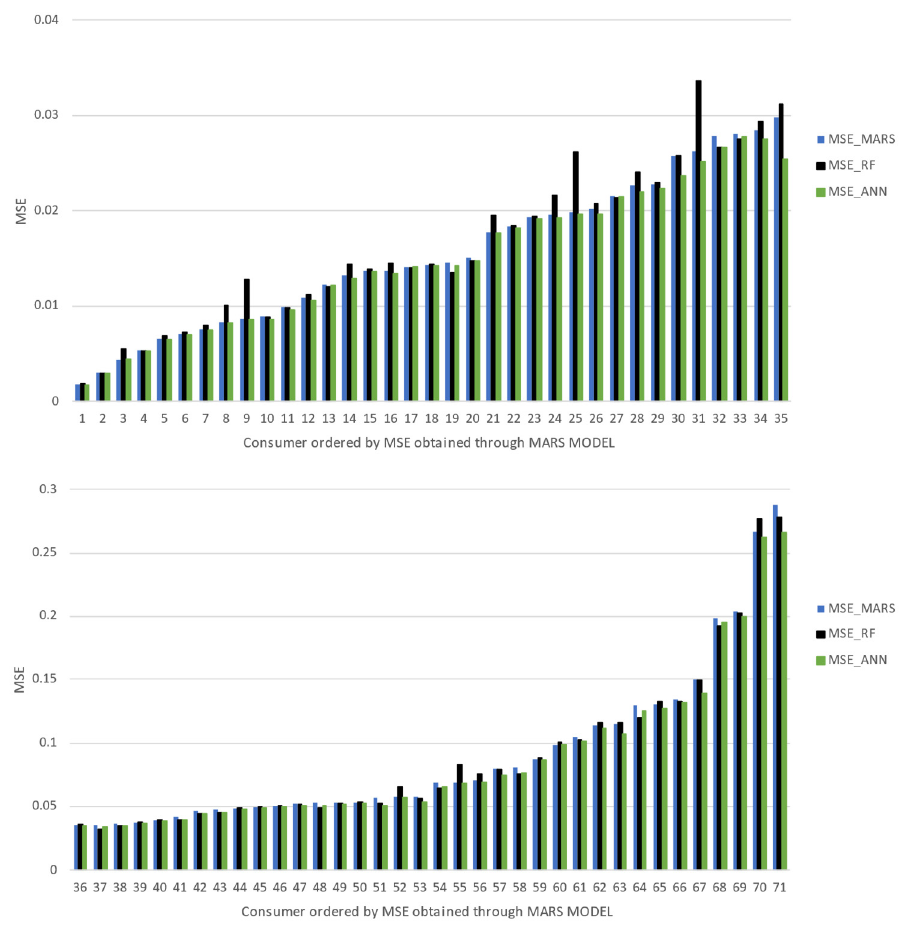
Figure 7. Bar charts involving MSE (in kWh 2 ) in an ascending order.